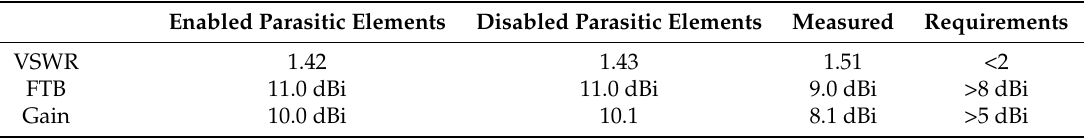
Figure 7. Numerical assessment, reference configuration one reflector and one director. Comparisons between numerical results (red line) and measured data, with parasitic elements disabled (blu cross) and completely removed (red cross). Table 1. Numerical assessment. Comparisons between computed and measured antenna parameters, with enabled and disabled parasitic